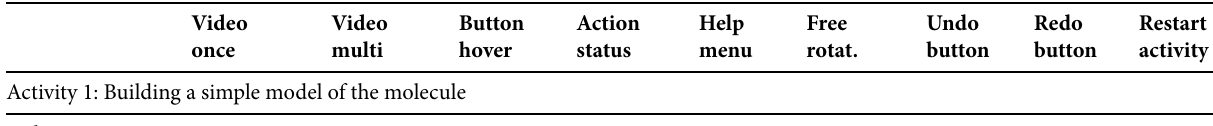
Table 14: Spearman correlations between actions with help